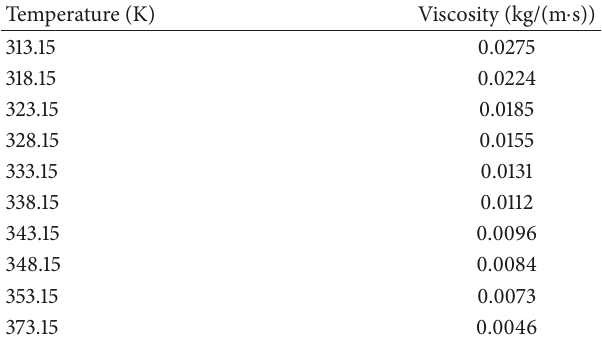
Table 2: Viscosity properties of ISO VG32.